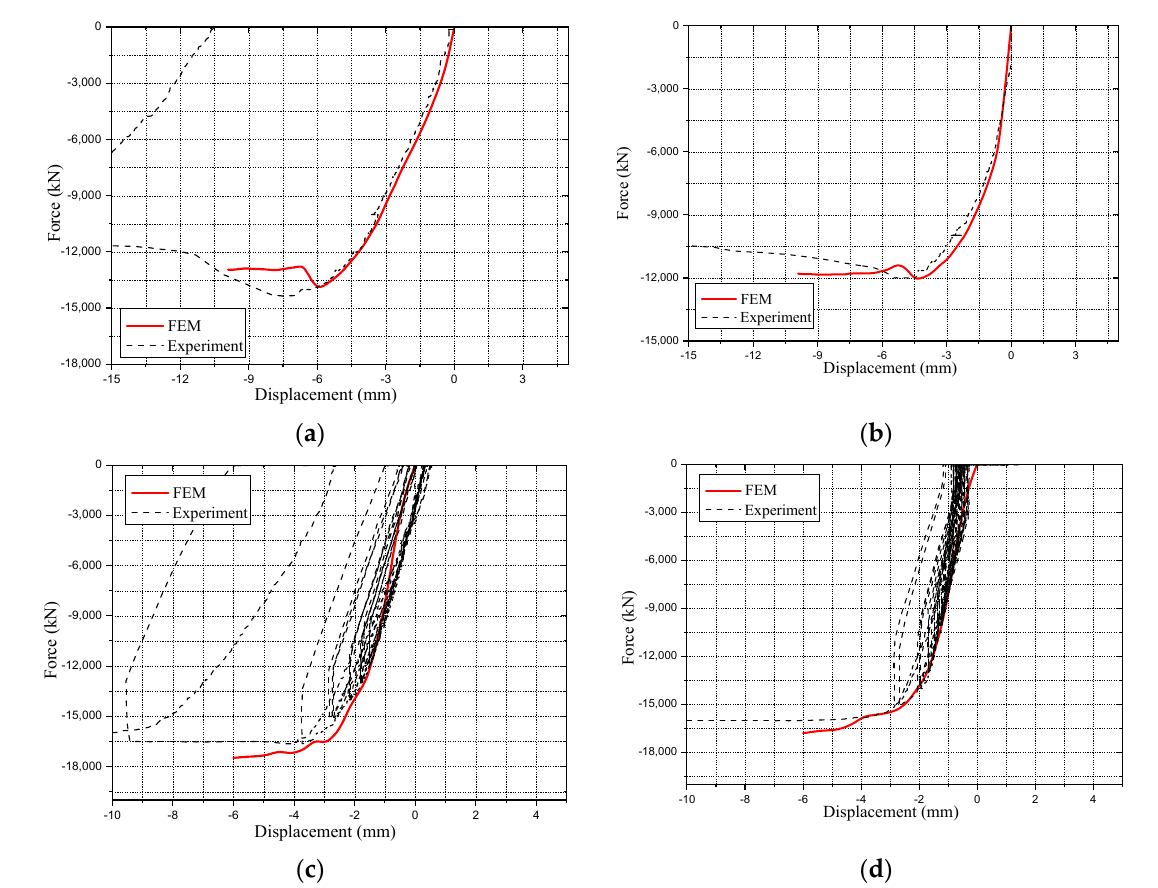
Figure 13. Comparison between the FEM results and the experimental ones. ( a ) PEN1; ( b ) PEN3; ( c ) PEN5; ( d ) PEN6.